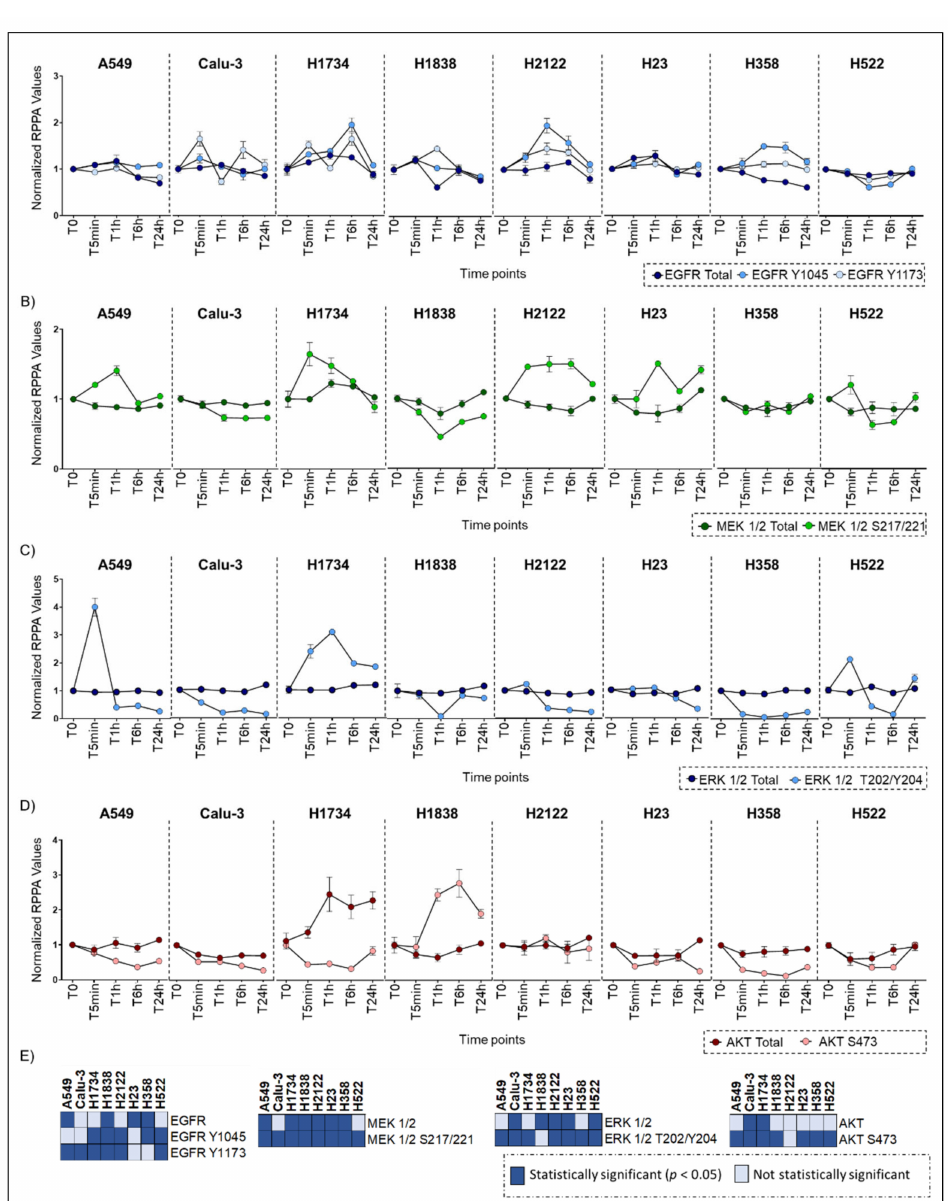
Figure 6. Low-dose DMSO effects on the expression and activation of selected proteins across timepoints ( n = 5). Line plots display the heterogeneous effects of the solvent on selected protein across eight NSCLC cell lines at the DMSO C1 concentration. EGFR (Panel A ), MEK 1/2 (Panel B ), ERK 1/2 (Panel C ), and AKT (Panel D ) are displayed. Mean and standard error of the mean for the technical replicates ( n = 3) are shown. Changes that emerged as statistically significant across timepoints using the Kruskal-Wallis test are shown in (Panel E